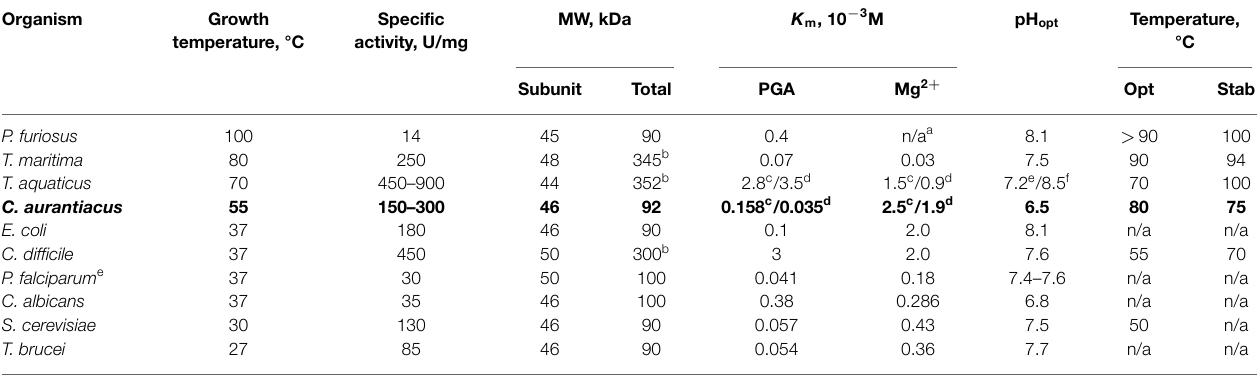
a Not applicable. b Total molecular weight for octameric structure. c Measured at 25°C. d Measured at optimum temperature. e Expressed in E. coli. f Obtained at the optimum temperature.